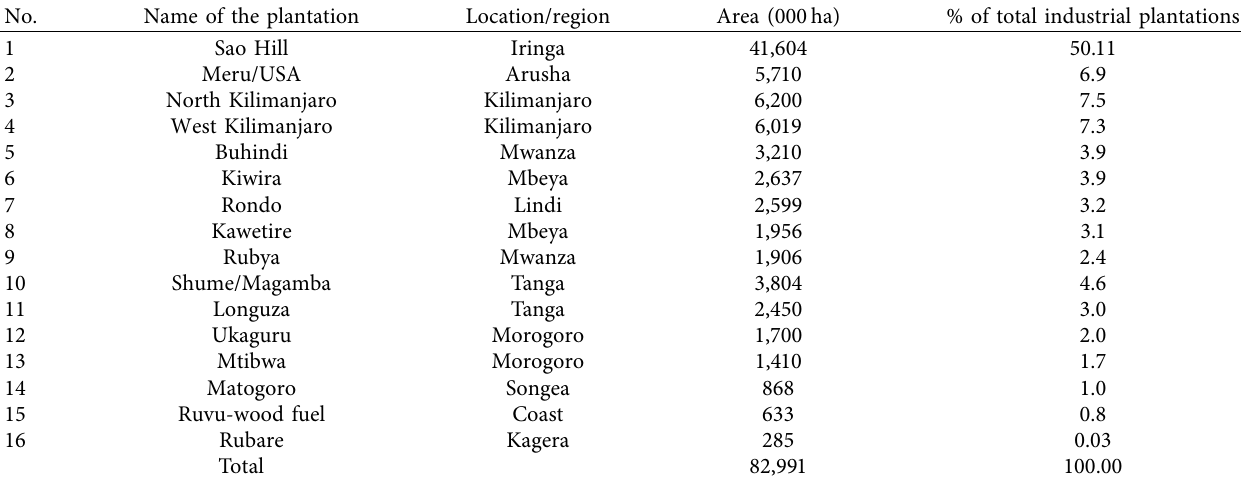
Table 2: List of government-owned forest plantations in Tanzania.